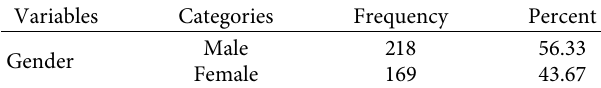
Table 2: Demographic gender of respondents.